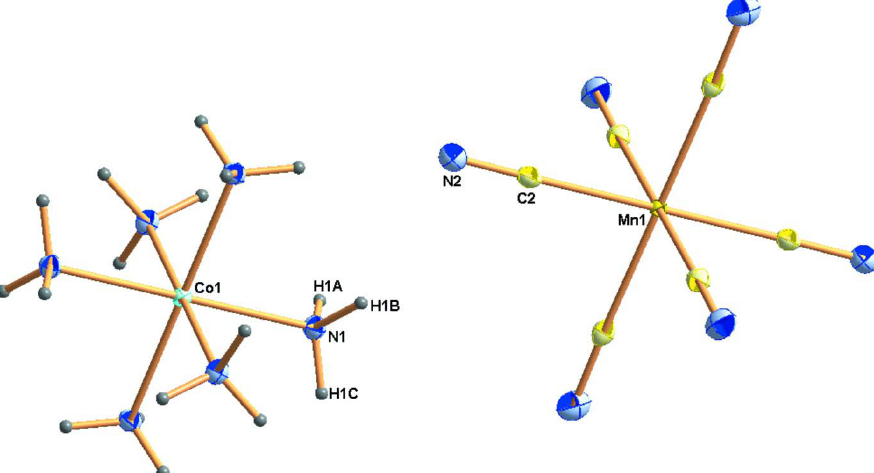
Figure 1 An ellipsoid plot of the title compound (50% probability displacement